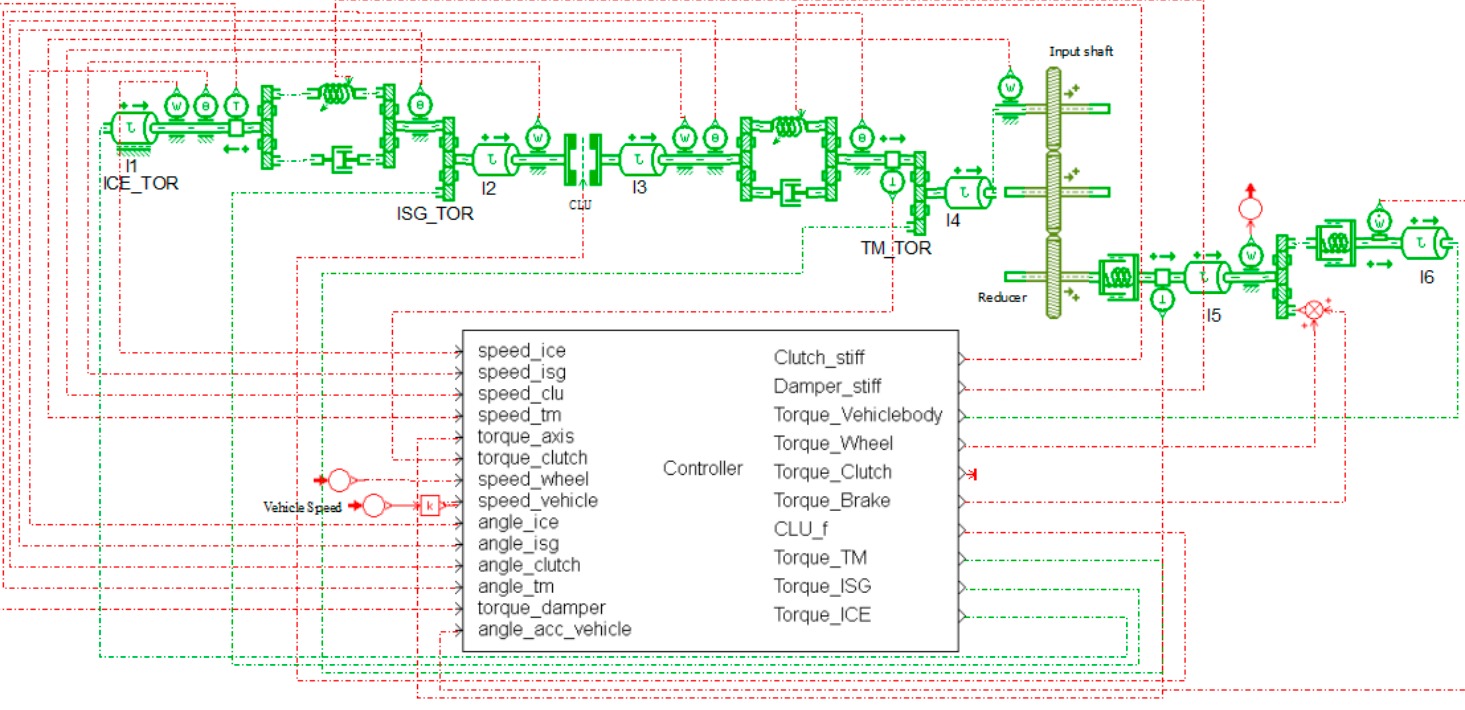
Figure A1. Dynamic model in AMESim.